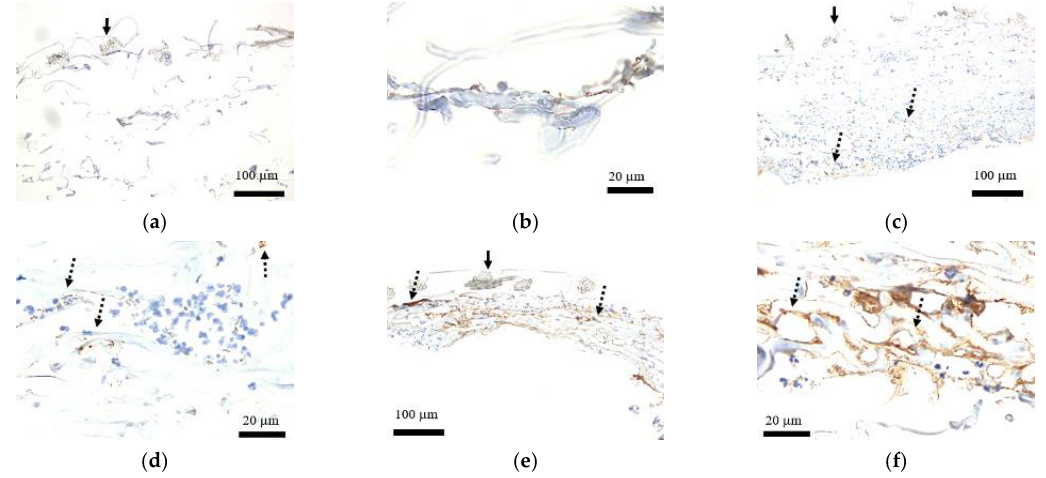
Figure 7. Staining of Factor VIII within the artificial dermal scaffold. ( a ) Low power field of view before transplant (40 × ): Blood cells were detected within the collagen sponge; however, no tissue was positive with Factor VIII. Solid arrow represents silicone film. ( b ) High power field of view before transplant (200 × ): Blood cells were detected within the collagen sponge; however, no tissue was positive with Factor VIII. ( c ) Low power field of view postoperative day 3 (40 × ): Some cells were stained with Factor VIII (dashed arrows). Solid arrow represents silicone film. ( d ) High power field of view postoperative day 3 (200 × ): Some cells were stained with Factor VIII (dashed arrows). ( e ) Low power field of view postoperative day 7 (40 × ): An increase in Factor VIII-stained cells were seen (dashed arrows). Solid arrow represents silicone film. ( f ) High power field of view postoperative day 7 (200 × ): Part of the cells stained with Factor VIII formed lumen-like structures (dashed arrows).